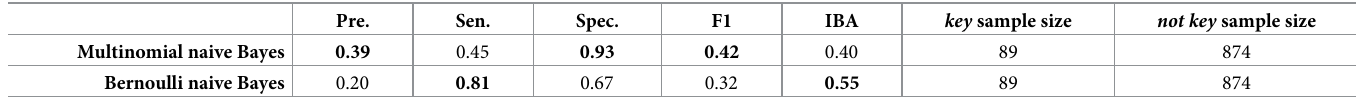
Table 2. Evaluation of the key confirmed-case count extraction. Pre. Sen.